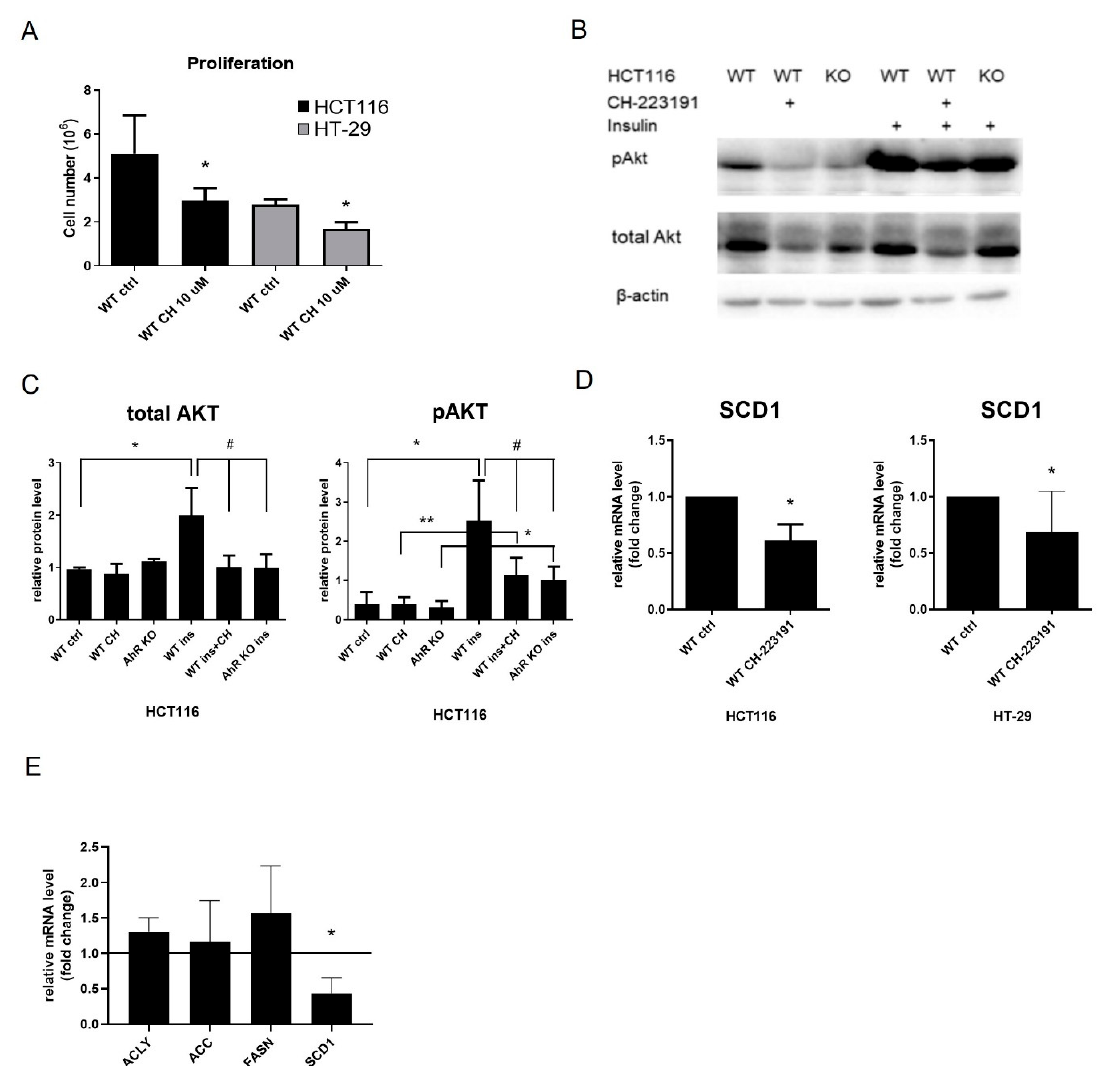
Figure 6. The AhR antagonist CH-223191 interferes with proliferation, Akt pathway activity and SCD1 expression in colon carcinoma cells. ( A ) Cells were treated with CH-223191 (10 µ M), 24 h after their seeding, and cell numbers were determined after 48 h treatment. The data are shown as means + SD of at least three independent experiments. * denotes a significant difference ( p < 0.05) between CH-223191-treated and control cells. ( B , C ) HCT116 cells were pre-treated with CH-223191 (10 µ M) for 48 h and then with insulin (100 nM) for 1 h. The levels of phosphorylated Akt (pAkt; Ser473) and total Akt were determined by Western blotting, with β -actin being used as loading control. Representative Western blot images are shown in ( B ). For original blots, see Supplementary File S1; the results of densitometry analysis, normalized to β -actin are shown in ( C ). The data are shown as means + SD of at least three independent experiments. * and ** denote a significant difference ( p < 0.05 and p < 0.01, respectively) between insulin-treated and the respective control cells. # denotes a significant difference ( p < 0.05) between control wild-type cells treated with insulin and insulin treated AhR KO cells or insulin-treated wild-type cells pre-treated with CH-223191. ( D ) SCD1 mRNA levels were determined in control HT-29 and HCT116 cells, and in cells treated with CH-223191 (10 µ M) for 24 h, by RT-qPCR. The data are shown as means + SD of at least three independent experiments. * denotes a significant difference ( p < 0.05) between control and CH-223191-treated cells. ( E ) Expression of FA synthesis/transport genes in WT (line) and AhR KO differentiated HepaRG cells (black bars). The data are shown as means + SD of at least three independent experiments. * denotes a significant difference ( p < 0.05) between WT and AhR KO